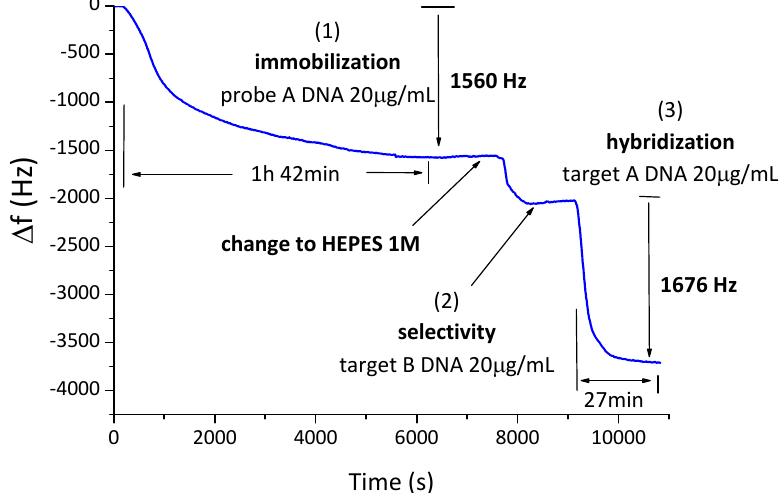
Figure 4. DNA-disulfide biosensor using the designed 50 MHz QCM oscillator circuit: frequency changes during successive circulation of 20 μ g/mL DNA-disulfide probe A NaCl solution ( 1 ), 20 μ g/mL DNA target B HEPES solution ( 2 ), 20 μ g/mL DNA target A HEPES solution ( 3